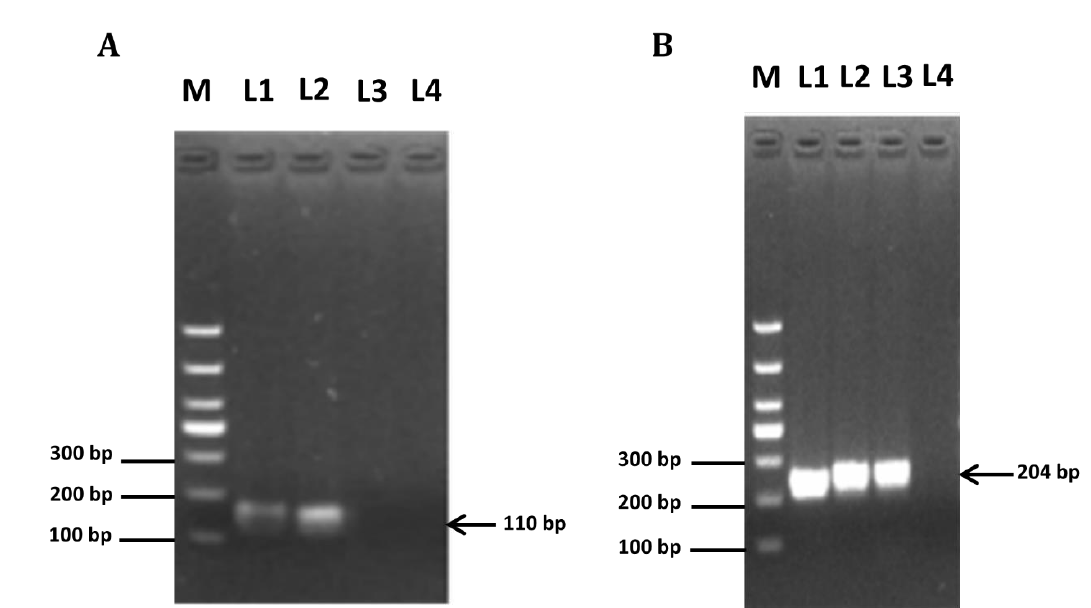
Figure 1. Expression of Amh and Amhr in mouse cumulus cells and oocytes. PCR amplification product of representative agarose gel electrophoresis. RNA was isolated from cumulus cells (Lane 1), cumulus oocyte complexes (Lane 2), and cumulus-free oocytes (Lane 3). One-microliter amounts of cDNA were used as templates for Amh ( A ) and Amhr ( B ) amplification, ddH 2 O was used as negative control for PCR amplification (Lane 4).